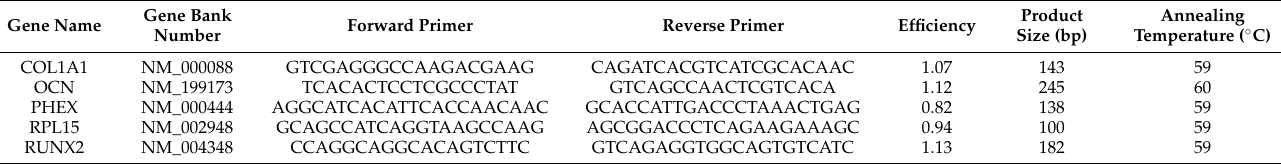
Table 4. Characteristics of the primers used for real-time